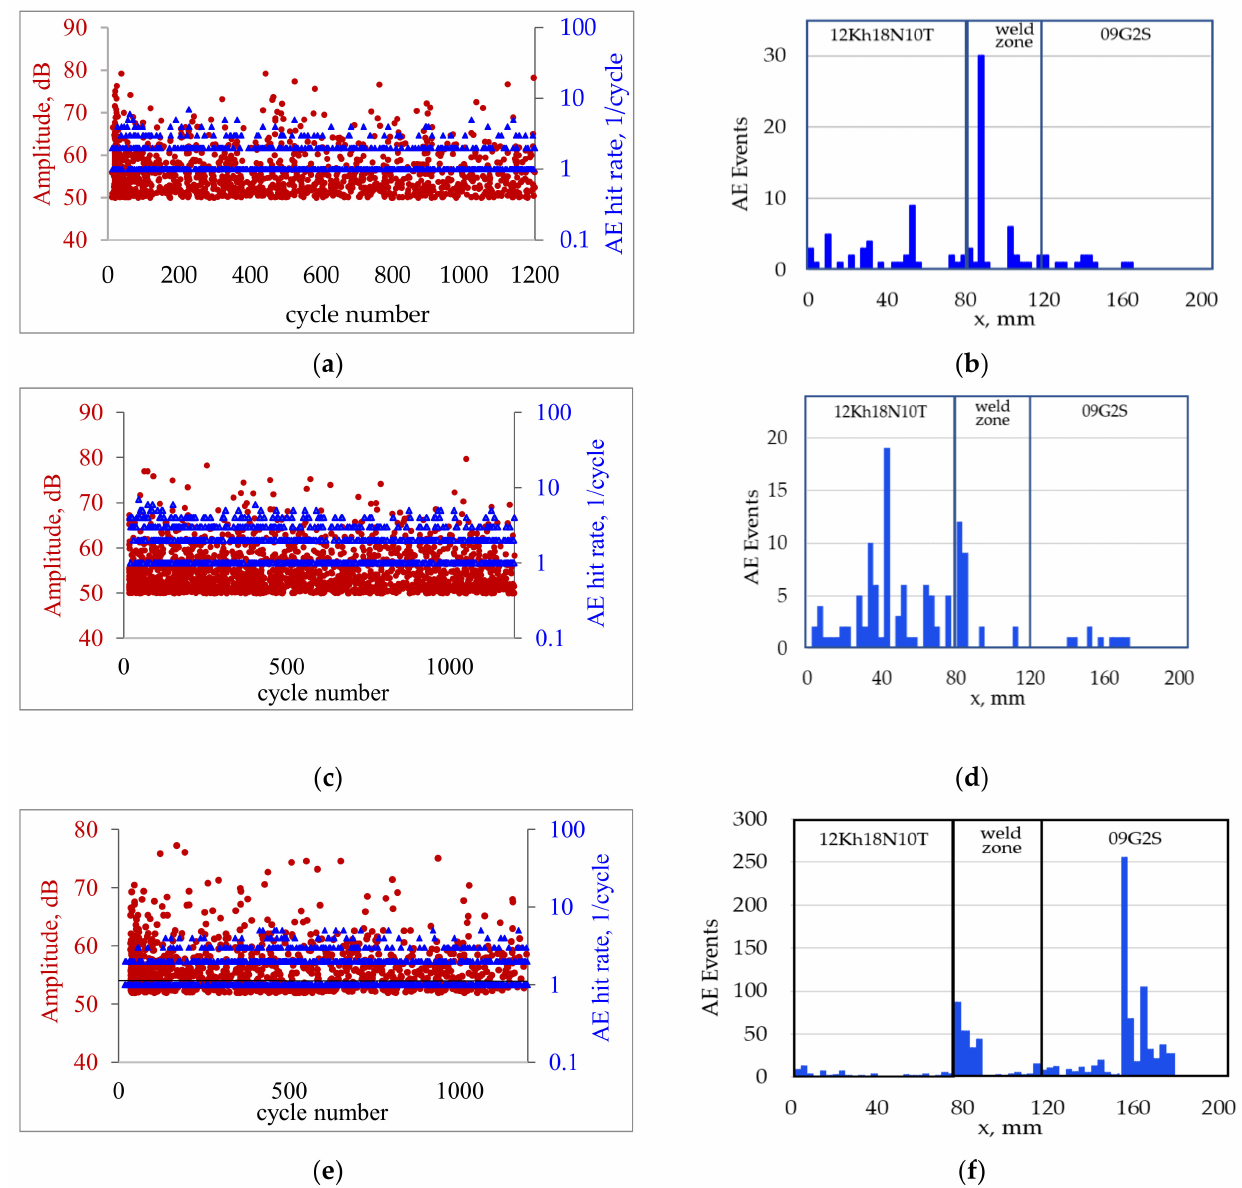
Figure 9. AE data obtained during cyclic loading of a welded joint with diffusion interlayers. Location of AE events at σ max = 200 MPa ( a ), σ max = 300 MPa ( c ) and σ max = 400 MPa ( e ); AE hits count rate values at σ max = 200 MPa ( b ), σ max = 300 MPa ( d ) and σ max = 400 MPa ( f